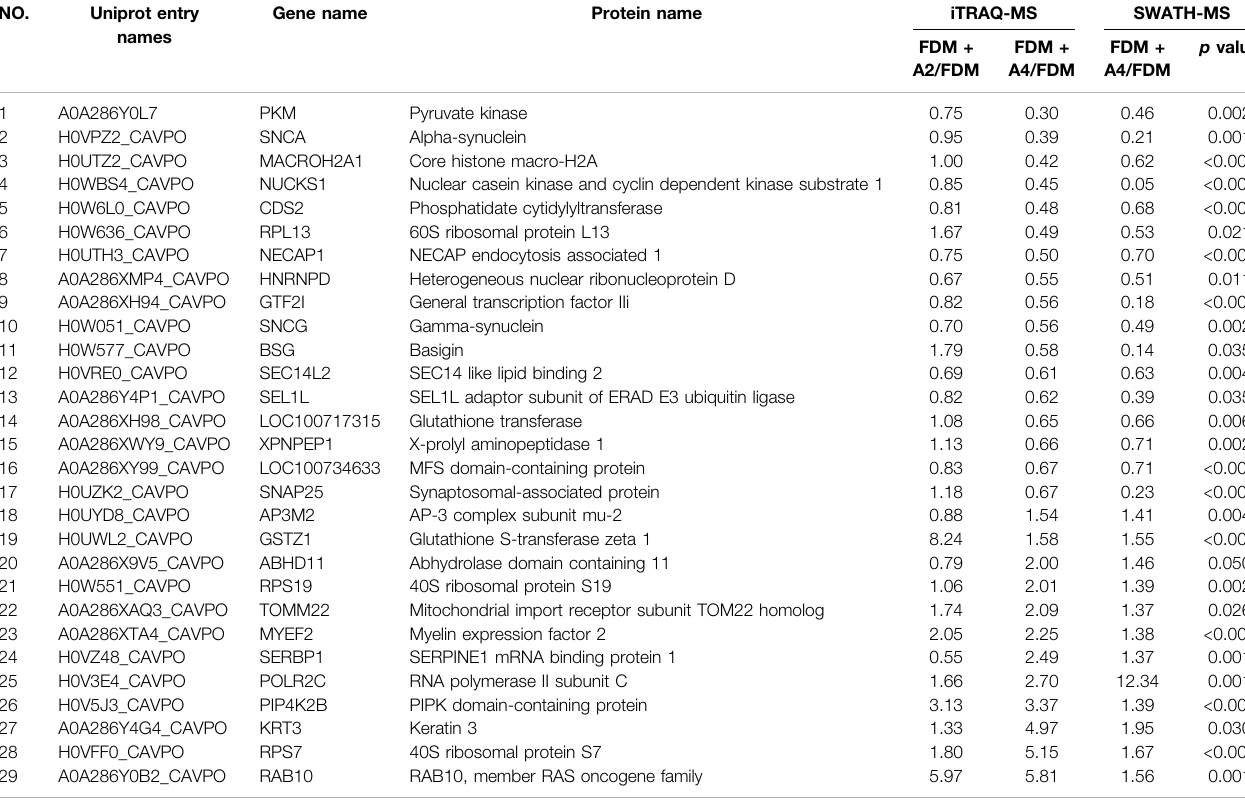
TABLE 1 | Twenty-nine commonly regulated proteins with the same directional expression change found in the FDM + A4 group compared to the FDM group by both the iTRAQ-MS and SWATH-MS approach meeting criteria for differential expression (iTRAQ: FC ≥ 1.5 or ≤ 0.67, SWATH: n = 6, FC ≥ 1.4 or ≤ 0.71, p -value of ≤ 0.05, welch T-test). Red represents up-regulated proteins and blue down-regulated proteins.